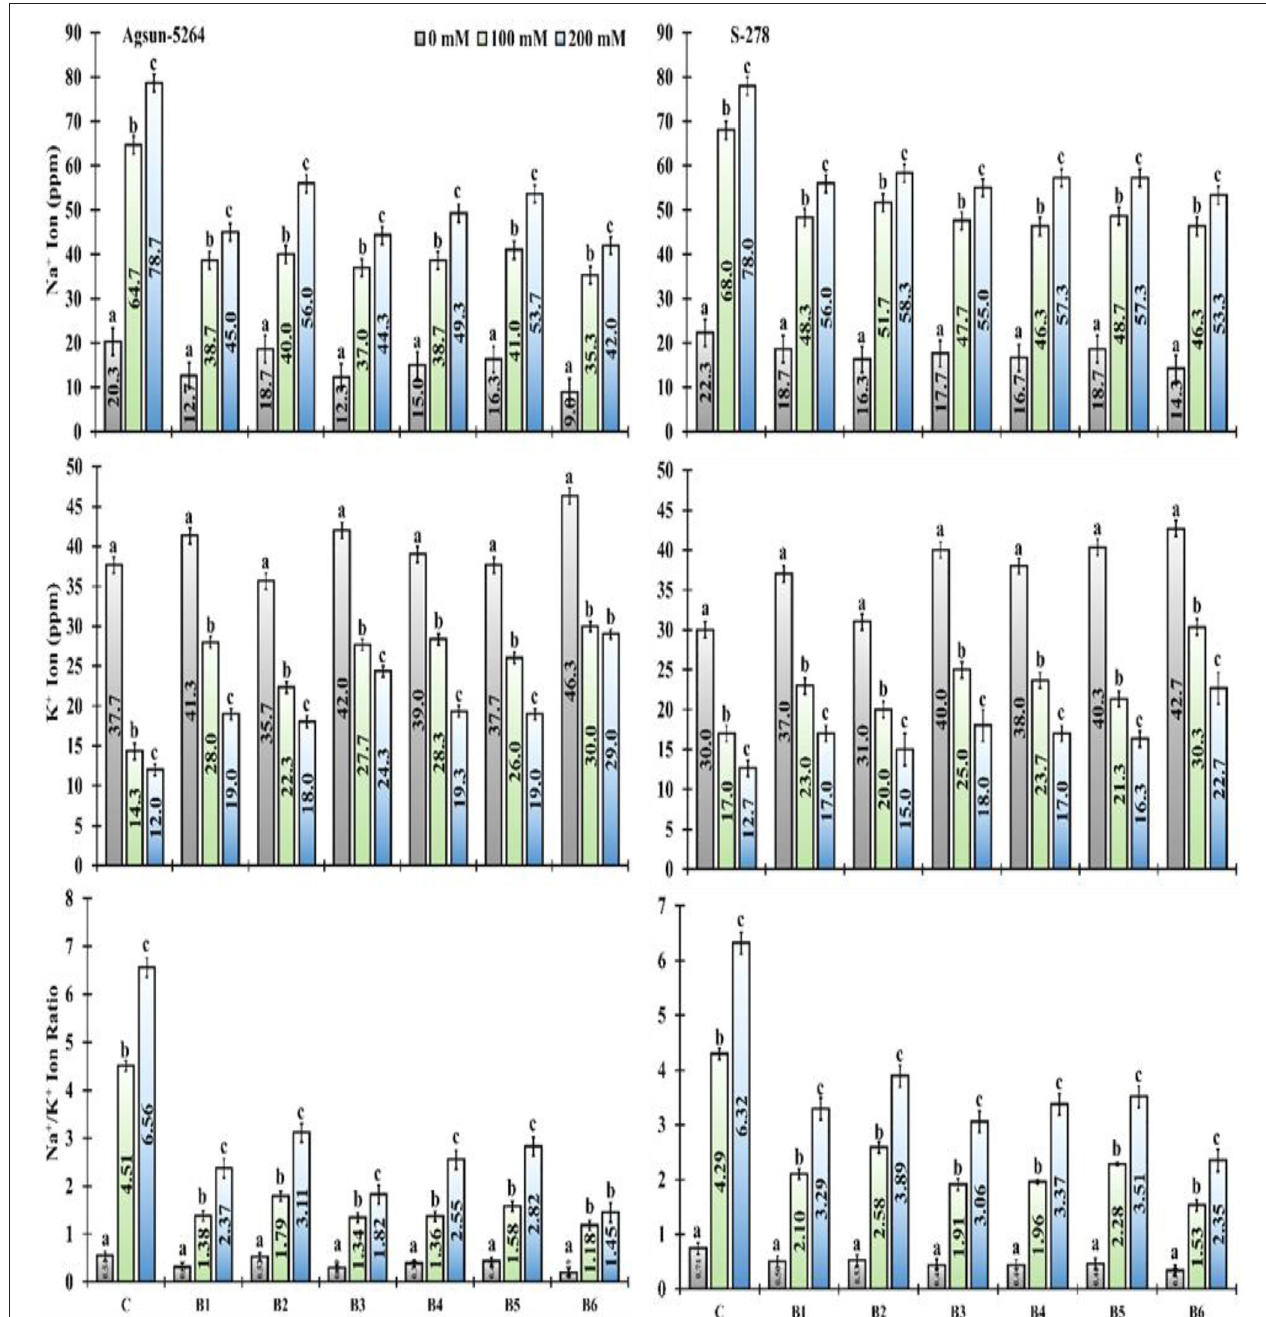
FIGURE 7 | Effect of halophilic microbial strains on changes in sodium ion (Na + ), potassium ion (K + ), and Na + /K + ratio of sunflower cultivars under salinity stress. Vertical bar lines express standard error (S.E) and similar letters on the error bar represent non-significant difference at p ≤ 0.05 ( Bonferroni post-hoc test ) between